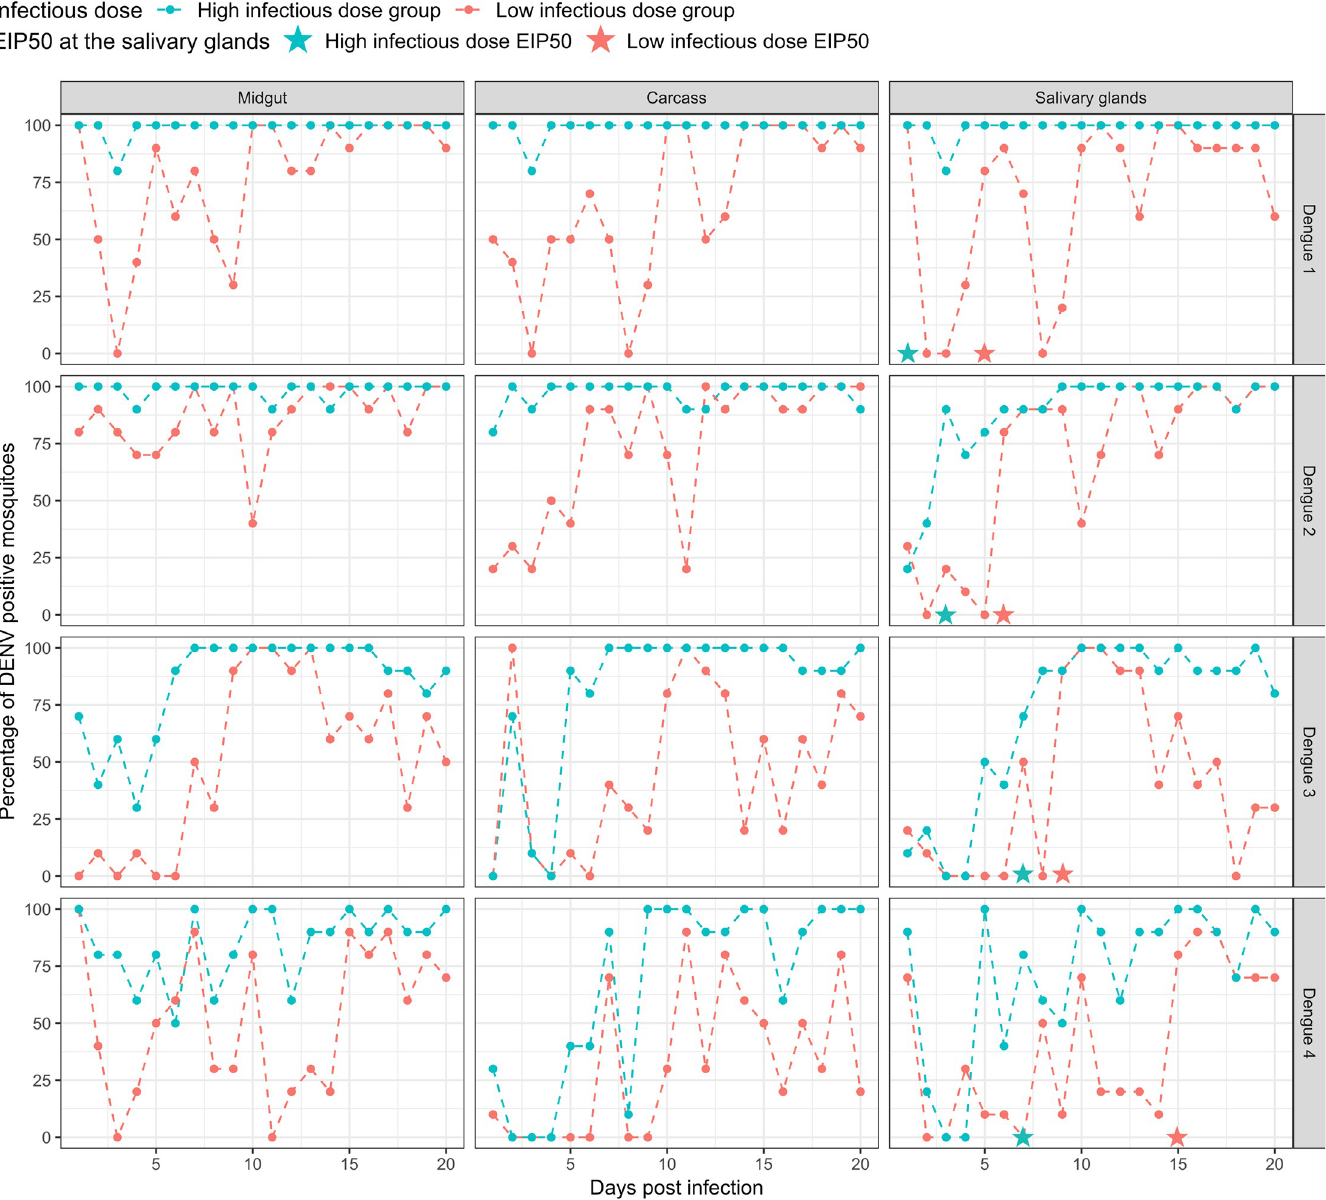
Fig 1. Susceptibility of DENV strains by DPI, tissue and infectious dose. The percentage of DENV infectious mosquitoes calculated daily out of 10 individuals. Low infectious dose in red and high infectious dose in blue. Stars represent EIP50 at the salivary gland for both infectious doses. Statistical analysis is presented in Table 2.